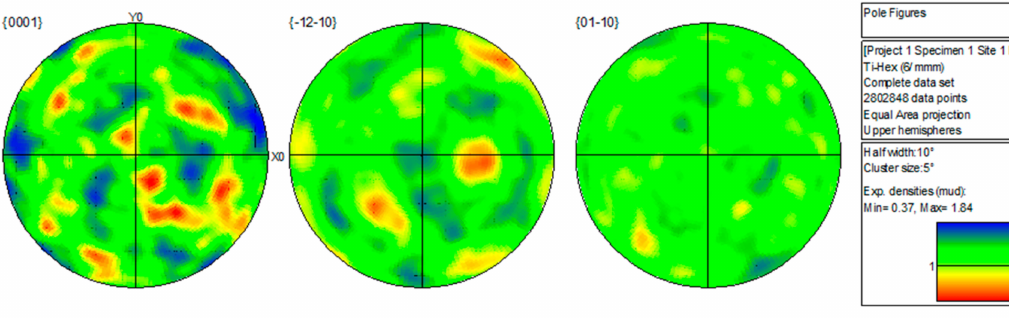
Figure 18. EBSD pole figures associated with Figure